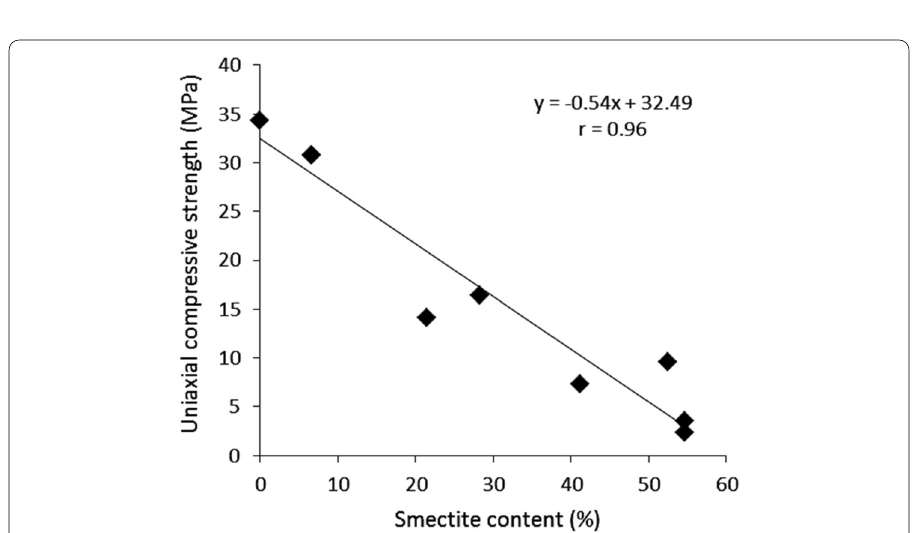
Fig. 13 Correlation between the UCS and smectite